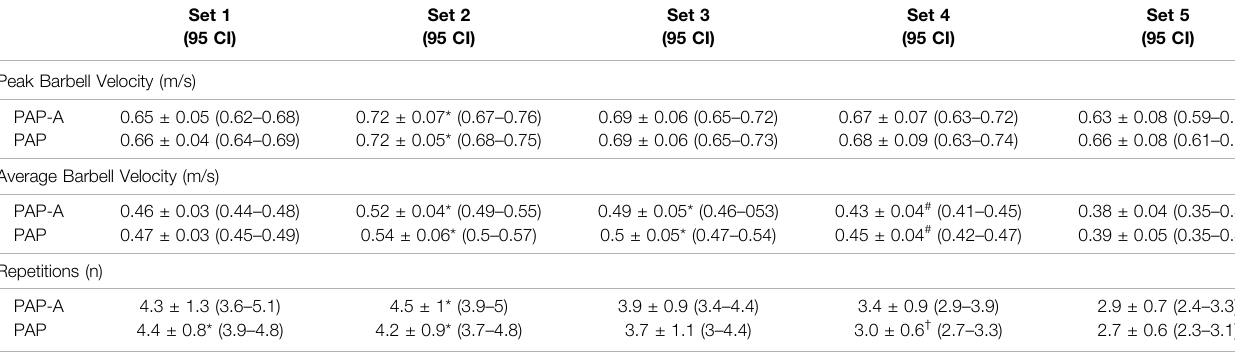
TABLE 1 | Comparison of conditioning activity (bench press) performance between